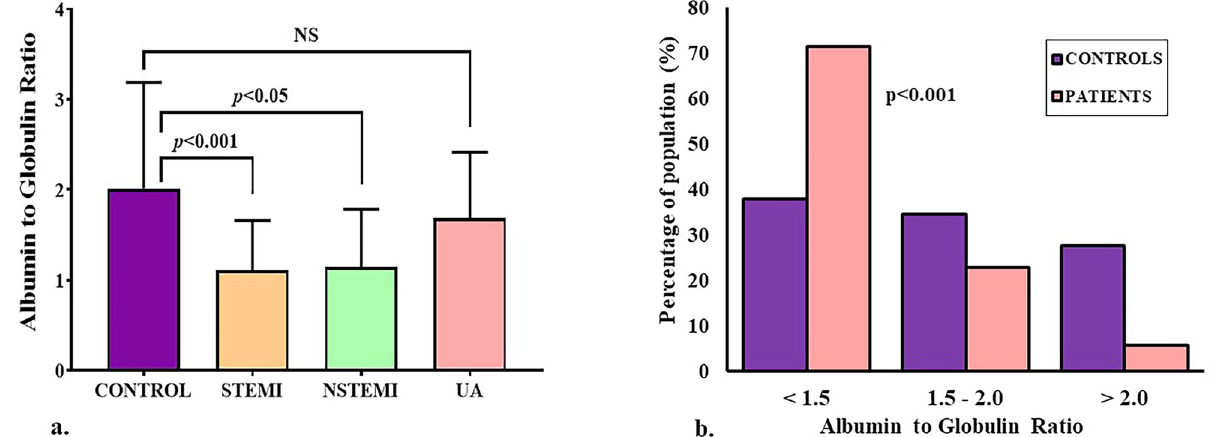
Fig 2. (a) Comparison of albumin to globulin ratios (AGR) between the controls and different subgroups of ACS cases . The mean AGR in STEMI and NSTEMI cases were significantly lower than the controls, while the differences in UA cases were not significant (NS). (b ) Comparison of the proportions of controls and ACS patients in different categories . Of the ACS patients, 71.4% had AGR lower than 1.5, 22.9% with AGR between 1.5 and 2.0, and 5.7% had values greater than 2.0; among the controls, 37.9% had AGR below 1.5, 34.5% ranged between 1.5 and 2.0, and 27.6% had AGR greater than 2.0 (p < 0.001, controls vs. patients, all